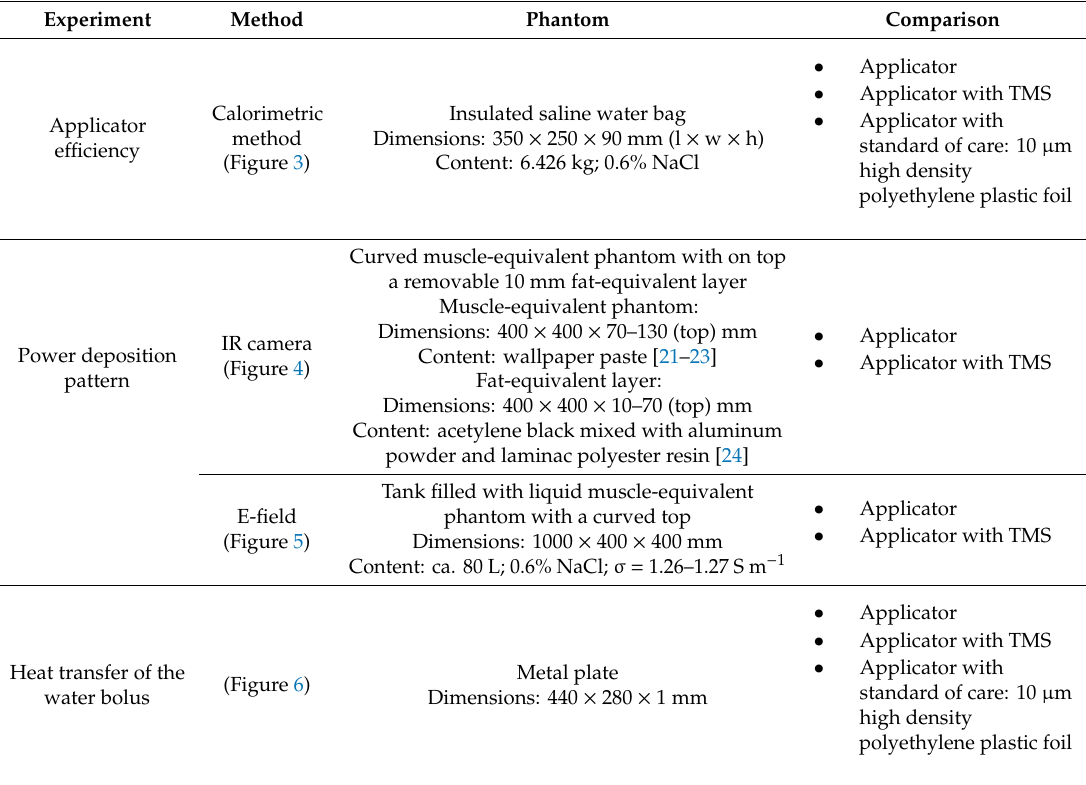
Table 2. Overview of the phantom